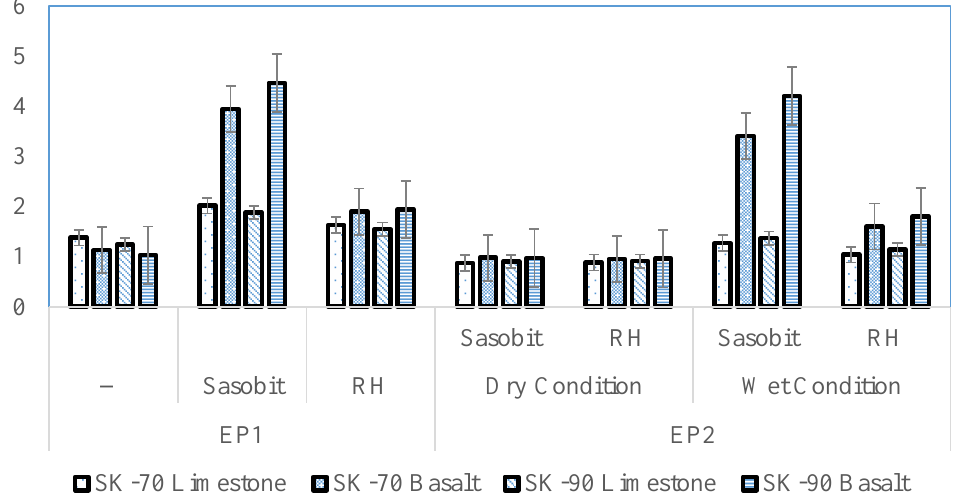
Figure 6. The EP 1 and EP 2 Values of Asphalt-Aggregate Interface in Different Systems.